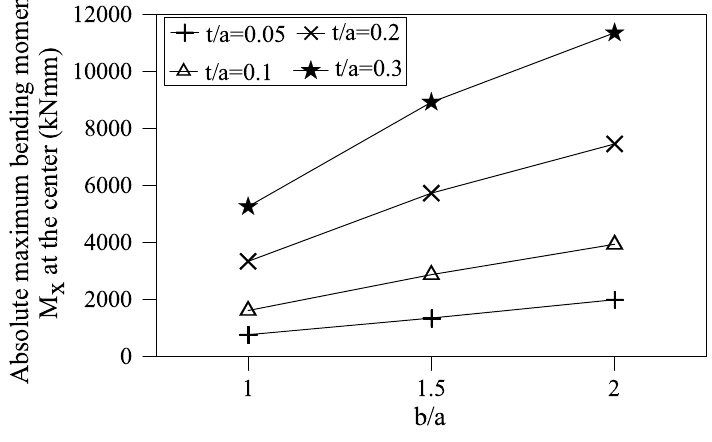
Fig. 8. Absolute maximum bending moment M x at the center of the thick simply supported plates for different aspect ratios and thickness/span